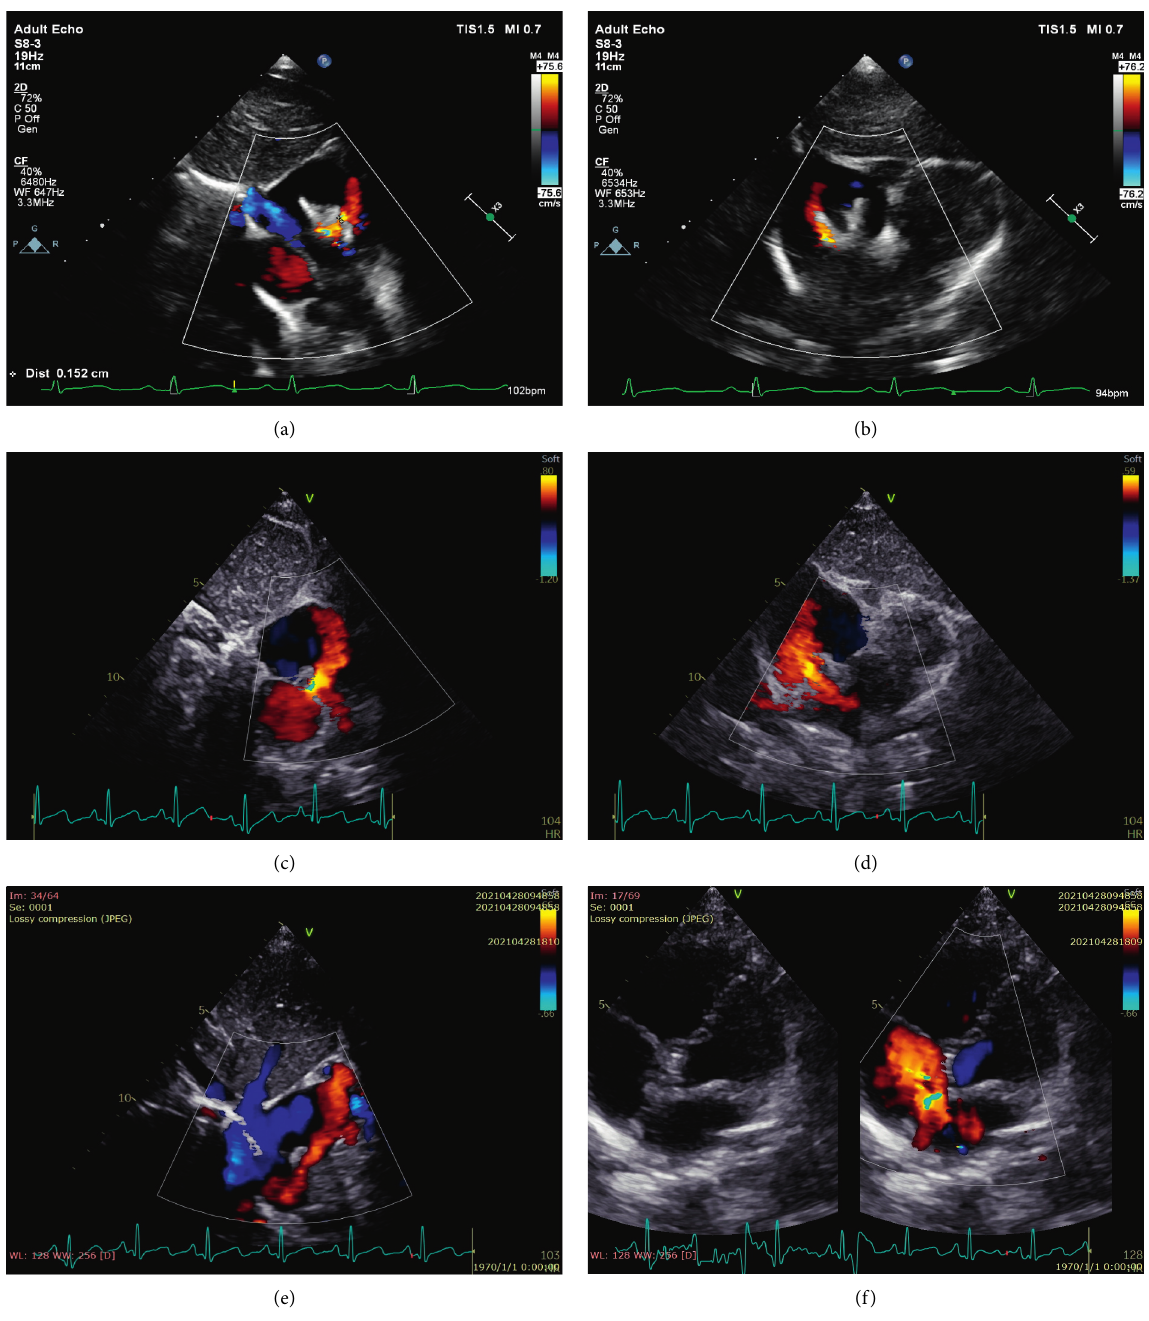
Figure 4: The development of residual shunt in Patient no. 2. (a-b) A mild residual shunt of 1mm was detected at the 12-month visit. (c-d) A moderate residual shunt of 3.7mm was detected at the 24-month visit. The device was partly degraded. (e-f) a large residual shunt of 4.3mm was detected at the 36-month visit. The device was mostly